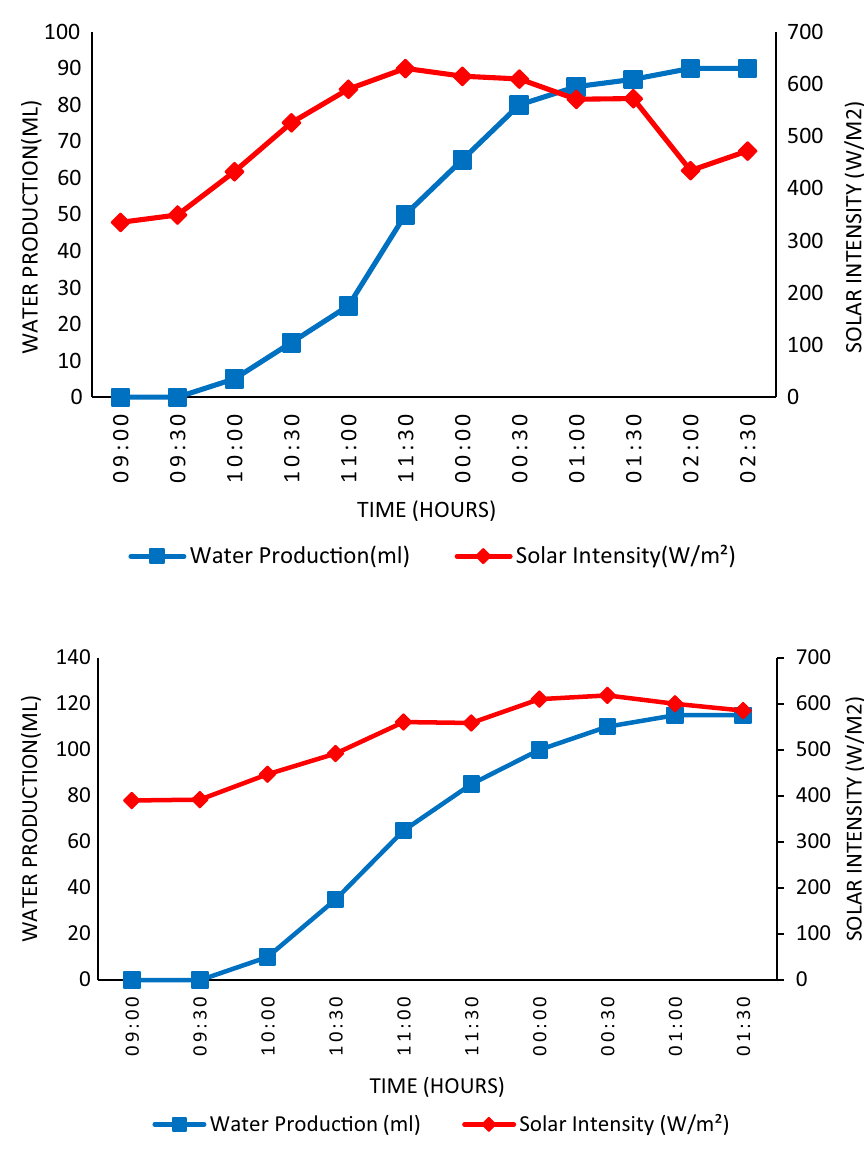
Fig. 6 Variation of water production with solar intensity w.r.t. time for LiCl/River Sand